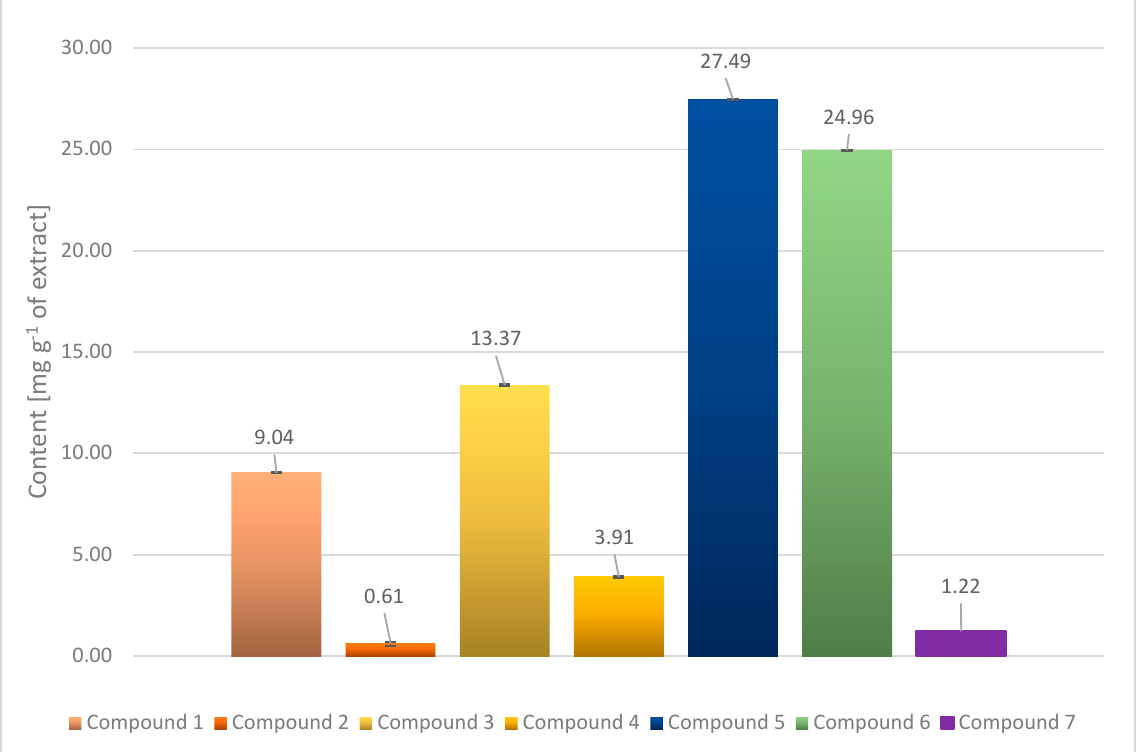
Figure 2. Content of polyphenols in V. samygdalina leaf extract. Values are reported as mean±SE ( n = 15 of UHPLC analyses).